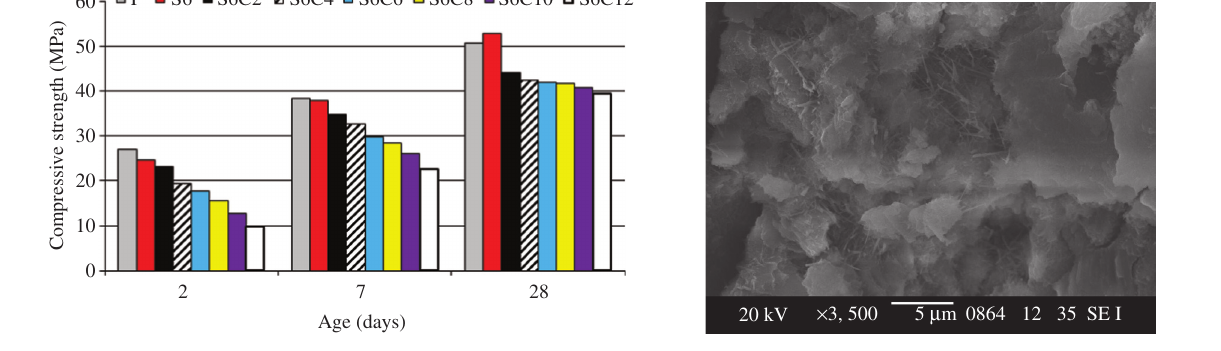
Figure 9 Compressive strength of mixtures according to